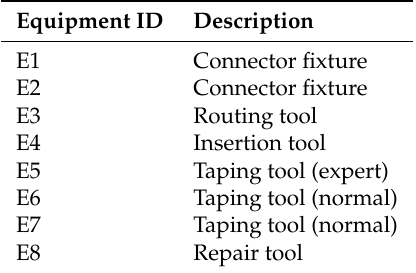
Table 3. List of equipment that should be allocated in the line balancing